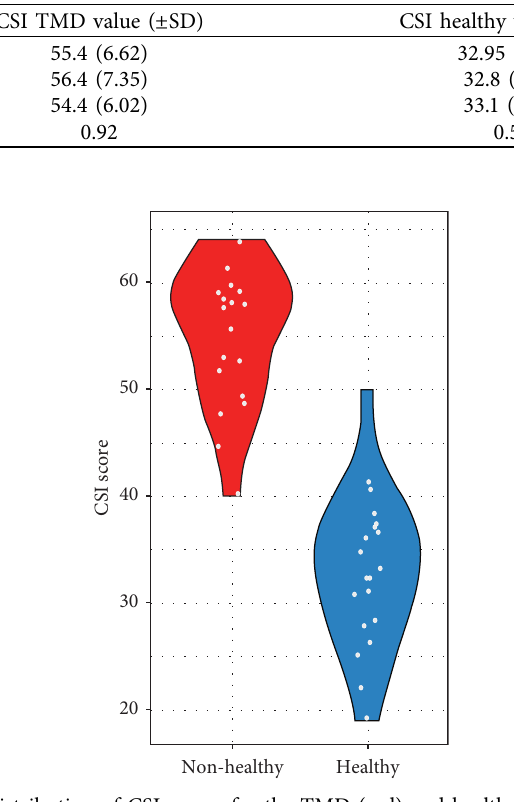
Figure 1: Distribution of CSI scores for the TMD (red) and healthy (blue) groups. Table 2: EMG values for specific muscles in the TMD and healthy subjects with eyes open (EO) versus eyes closed (EC). Muscle